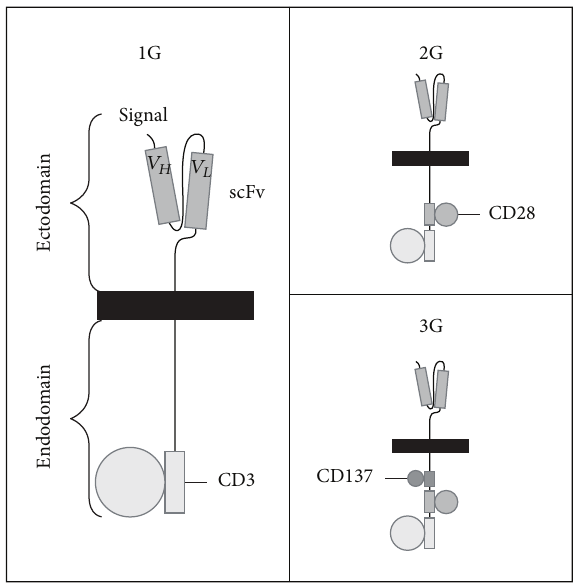
Figure 2: Different generations of chimeric antigen receptors (CARs). Left to right, top to bottom. First-generation CARs consist of scFv fragment against a tumor antigen (e.g., GD2 in neurob- lastoma, CD19 in B-cell malignancies) linking a CD3 signaling chain. Second- and third-generation CARs incorporate 1 or 2 costimulatory molecules, respectively (e.g., CD28, CD137). 1G: first generation; 2G: second generation; 3G: third